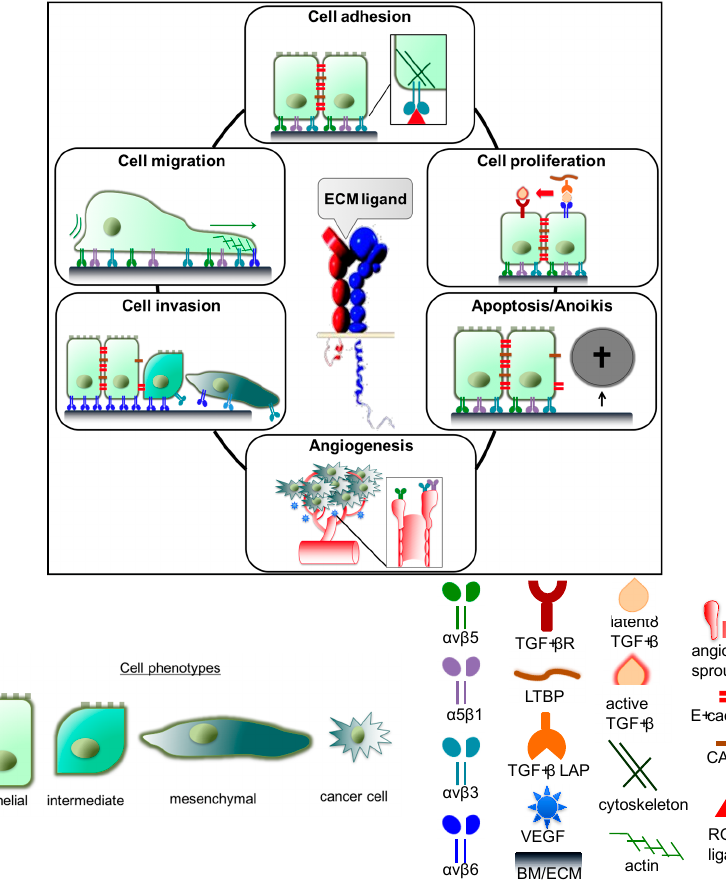
Figure 2. Integrin functions are instrumental in tumor biological contexts. Integrin functions are involved in various tumor biological processes, including cell adhesion, proliferation, inhibition of apoptosis/anoikis, induction of angiogenesis, cell invasion and migration. Adhesion: Cell adhesion is mediated by integrin binding to the respective recognition motif of RGD-ligands within the ECM, e.g., fibronectin, osteopontin and vitronectin. Binding of RGD ligands to integrins enables communication between the ECM and intracellular components, such as the cytoskeleton. Proliferation: Cell proliferation, mediated by integrin subtypes, such as α v β 3, α v β 6, and α v β 8 may also be induced upon the binding of the RGD-containing latency associated peptide (LAP) of the inactive TGF- β to integrins. Force between the TGF- β binding proteins (LTBP) and the TGF- β molecule results in the activation of the latent TGF- β . Subsequent binding of TGF- β to the TGF- β receptor (TGF- β -R) induces epithelial-mesenchymal transition (EMT) and cell proliferation. Apoptosis/anoikis: Further, integrin expression allows cells to bind to ECM molecules within a mesenchymal tissue context, thereby inhibiting apoptosis/anoikis of invasive carcinoma cells. Angiogenesis: Upon tumor growth, the expression of hypoxia induced factors and vascular endothelial growth factor (VEGF) results in the induction of integrin-associated vessel sprouting and angiogenesis. Invasion/migration: The integrin switch from α v β 1 and/or α v β 5 to α v β 6 allows cells to migrate and cross the basement membrane (BM) to invade the surrounding ECM as invasive cancer cells. This process is associated with EMT-like alterations of the cell phenotype. The EMT process involves the downregulation of E-cadherin and cell adhesion molecules (CAMs), promoting cell mobility, cancer progression and metastasis.